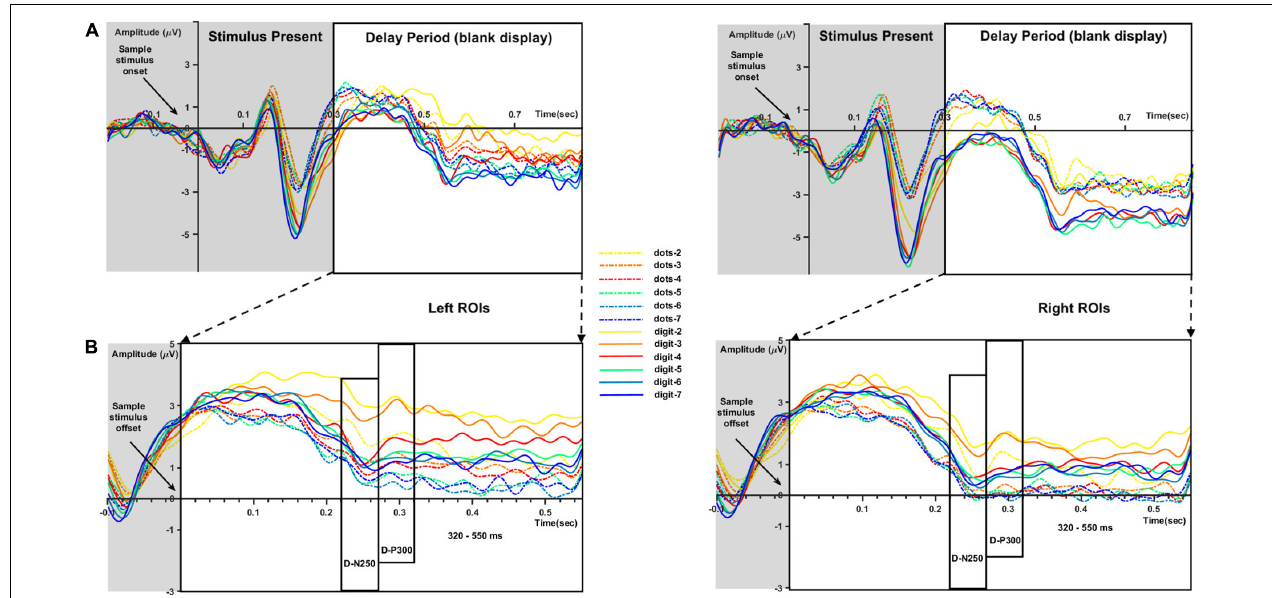
FIGURE 3 | ERP waveforms for each sample numerosity (different colors) and condition (dots-to-dots and dots-to-digit with full and dashed lines, respectively) in left and right regions of interest (ROIs). (A) Waveforms evoked by sample numerosity onset. (B) Extracted time windows corresponding to the delay period (blank display). We considered for analysis the negative deflections around 250 ms after sample numerosity offset (D-N250), the positive deflections around 300 ms (D-P300), and the final slow waveforms between 320 and 550 ms.